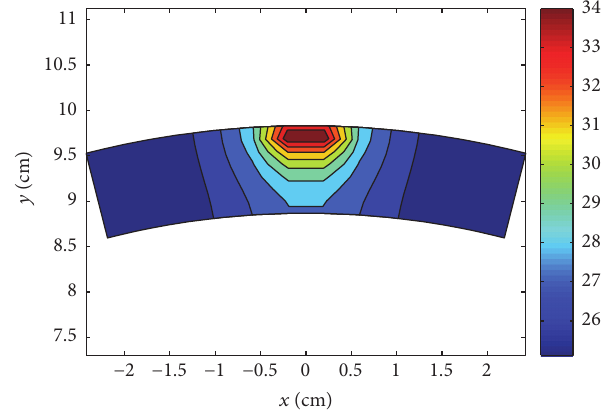
Figure 11: Temperature distribution at 𝑡 𝑓 = 30 s